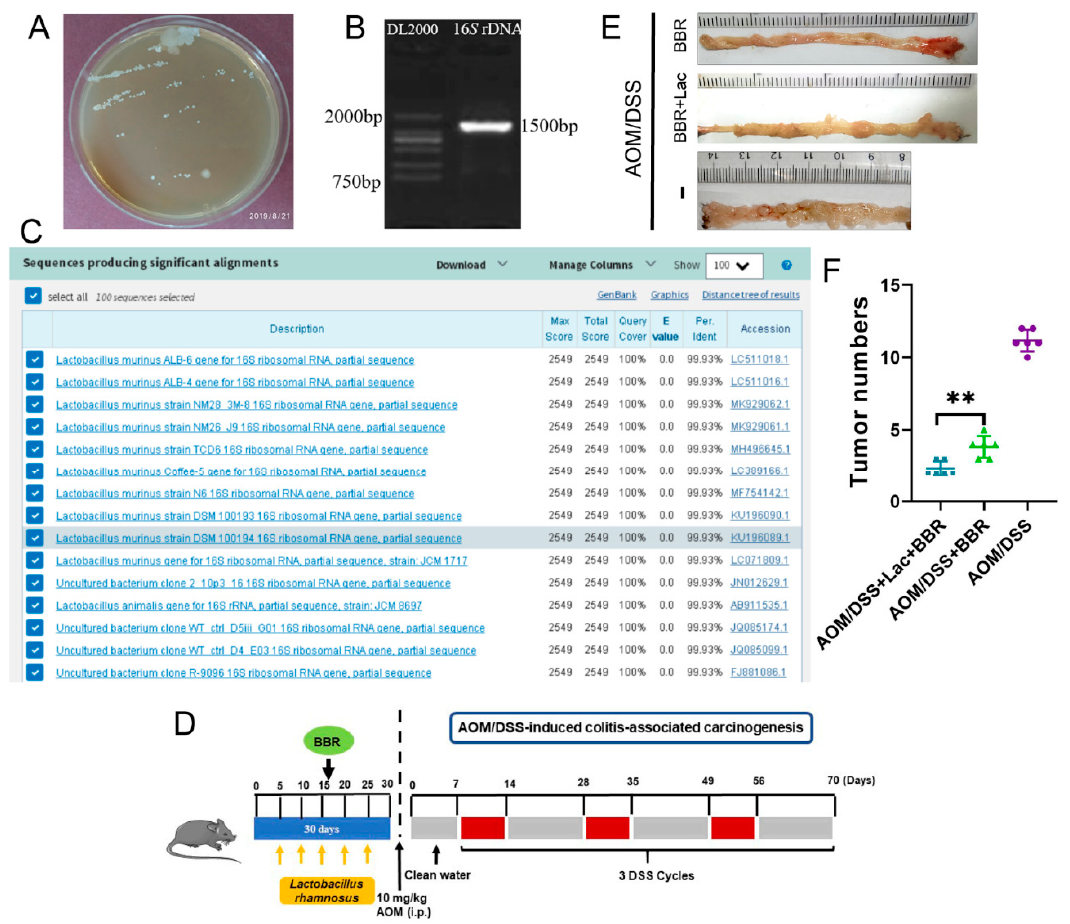
Figure 8. L. rhamnosus can promote the preventive effect of BBR on inflammatory colorectal cancer. ( A ) Screening of Lactobacillus by MRS bacterial medium. ( B ) PCR amplification and sequencing of bacterial 16S rDNA region. ( C ) Results of sequence homologous alignment in NCBI database. ( D ) Schematic diagram of bacterial solution, BBR intragastric administration and AOM/DSS treat- ment. ( E ) Representative gross images of colon tissues in each group ( n = 6). ( F ) Quantitative result showing the number of tumors in each group ( n = 6). Data are presented as mean ± SEM of the indicated number of independent experiments. ** indicates p <